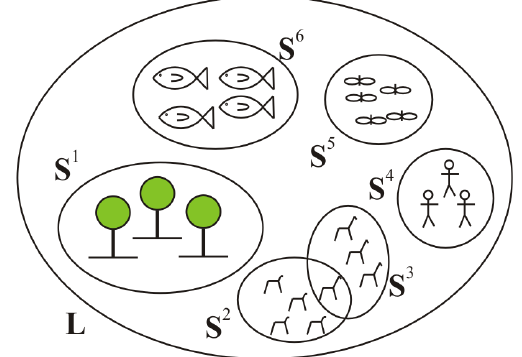
Figure 1. L is the set of all possible life-forms. S i are the sets of species.